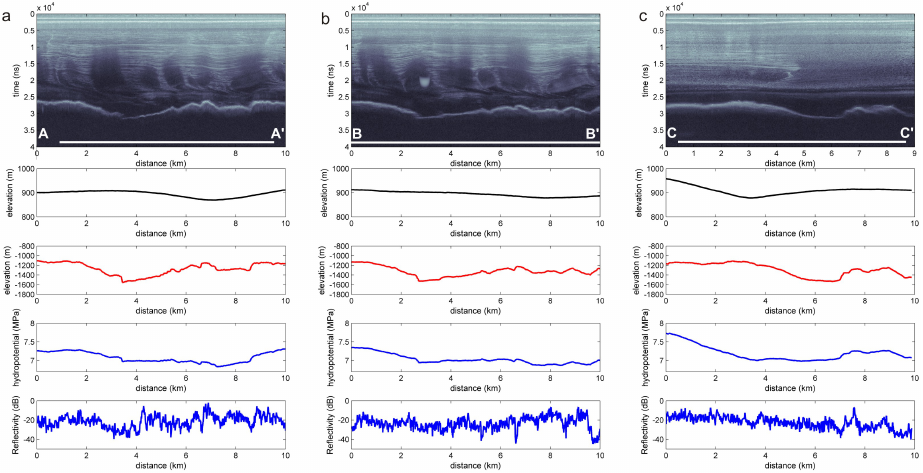
Fig. 7. RES transects centred on the “active” subglacial lake Institute E2. The locations of the transects are provided in Fig. 1b. (a) Transect A–A’. (b) Transect B–B’. (c) Transect C–C’. For each transect, the coverage of the ICESat-derived lake extent (after Smith et al., 2009) is shown as a white bar on the radargram. Beneath the radargrams graphs of ice surface elevation (black line), bed elevation (red line), basal hydropotential (upper blue line) and basal reflectivity (lower blue line) are